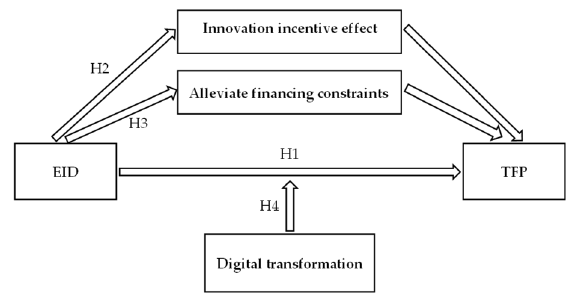
Figure 1. Theoretical framework diagram.